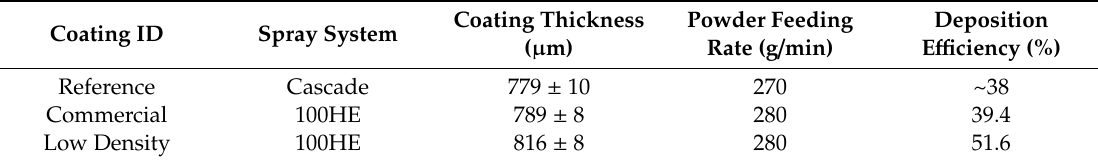
Table 3. Summary of investigated